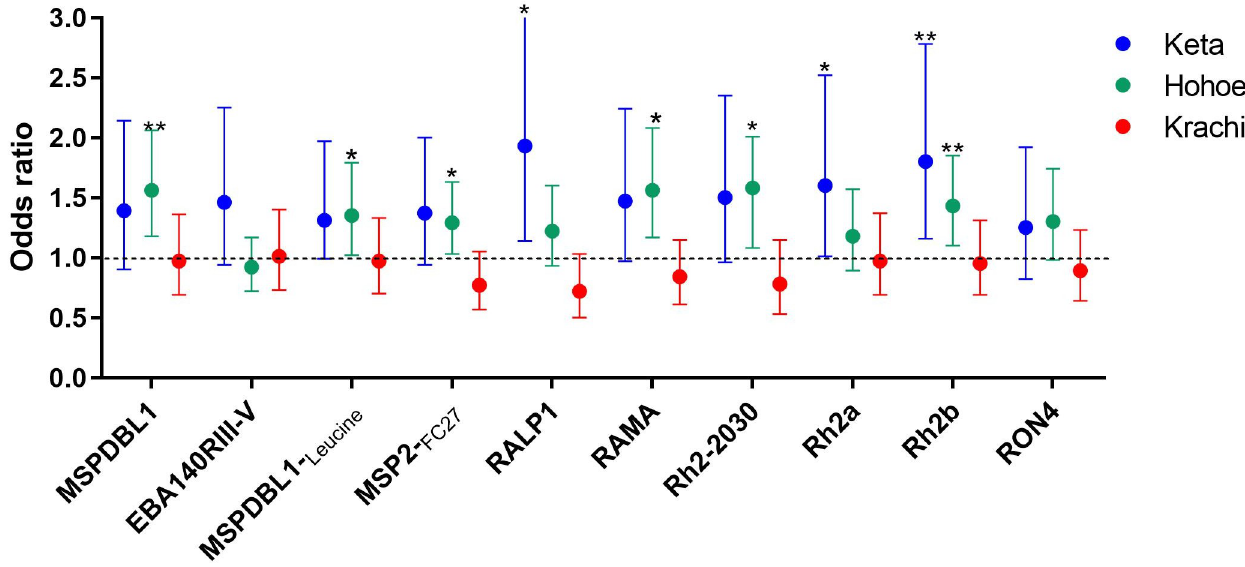
Fig 5. Total IgG responses are associated with parasite carriage. Multivariate logistic regression was used to predict parasite presence. Models were adjusted for age, ethnicity, bed net usage and district. Circles represent odds ratios and error bars are 95% confidence intervals. The black dotted line represents an OR of 1 which indicated no association with parasitaemia ( � p = < 0.05, �� p < 0.01, ��� p < 0.001, ���� p < 0.0001).